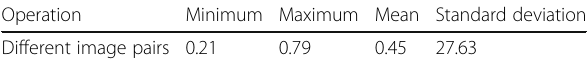
Table 9 Normalized hamming distance of 170 × (170 − 1)/2 = 14, 365 image pairs Operation Minimum Maximum Mean Standard deviation Different image pairs 0.21